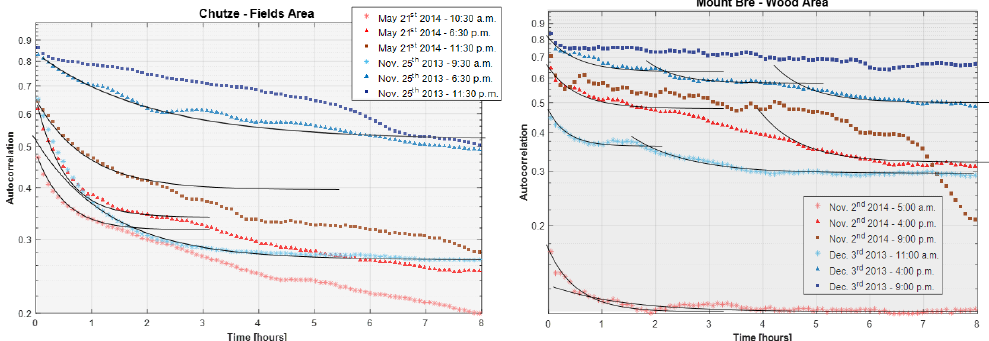
Figure 6. Time series of coherence over meadows ( left ) and forest ( right ) measured over eight hours for different times of the year, in the same two sites mentioned in Figure 5. The continuous line shows the fitting with exponential decays.